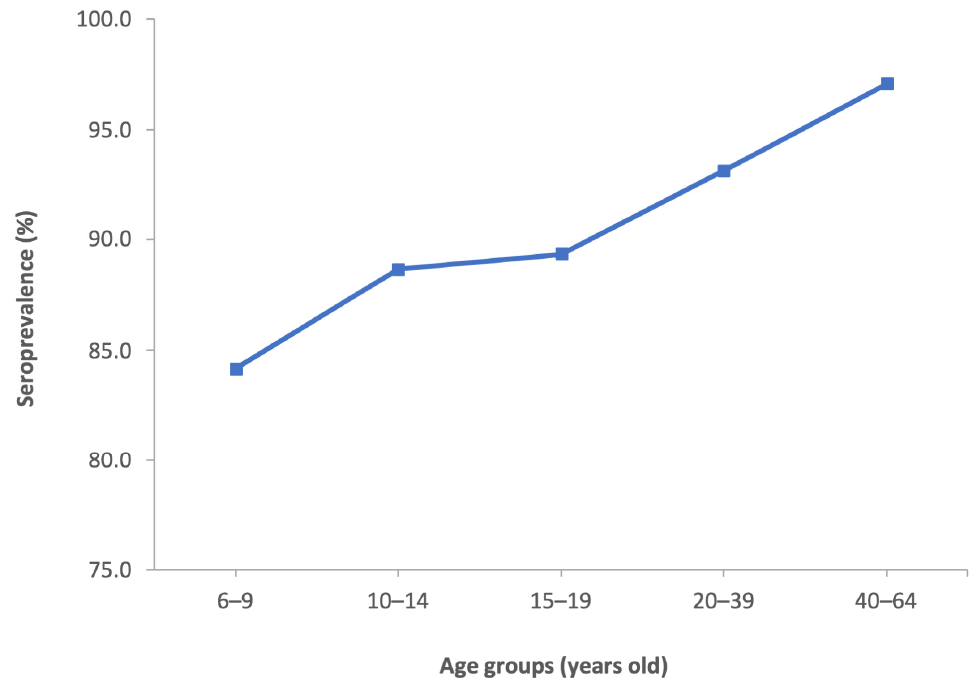
Figure 1. Seroprevalence of anti-VZV antibodies by age group in the Italian population. The distribution by geographical area shows an overall seroprevalence higher in Table 3. Seroprevalence (%) and relative 95% CI by age group in the Italian geographical Northern Italy (93%) and lower in Central (91.4%) and Southern Italy (90.6%). These dif- ferences were not significant ( p = 0.583) (Figure 2).